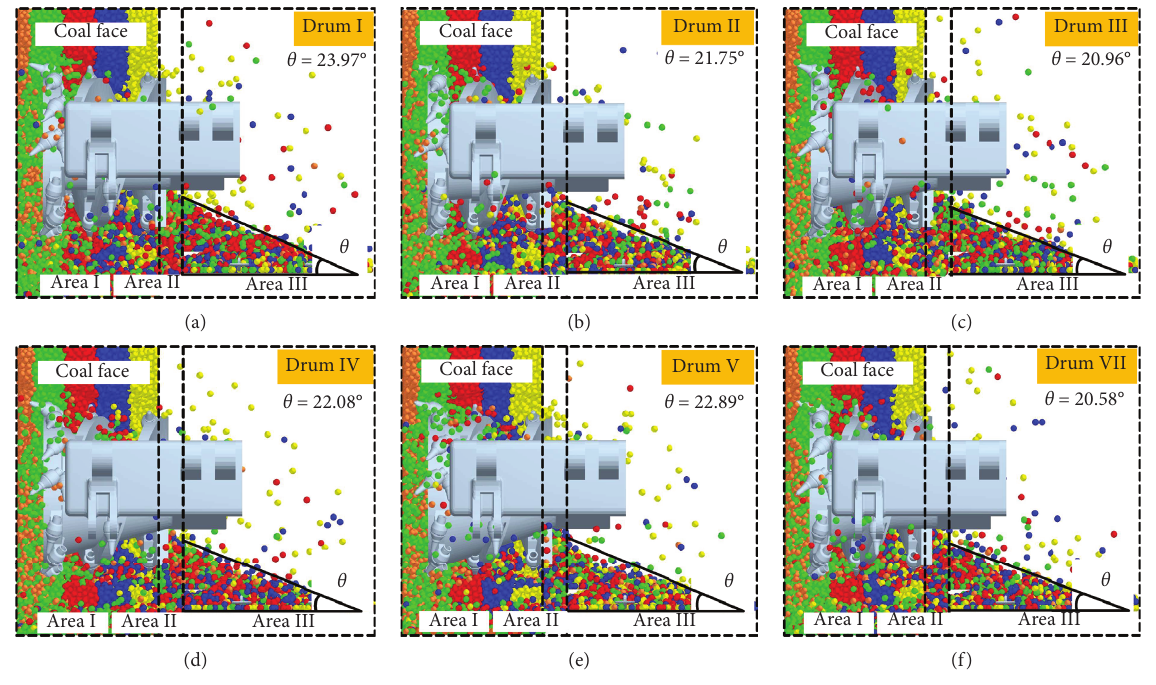
Figure 15: Simulation results in the DEM at rotational speed